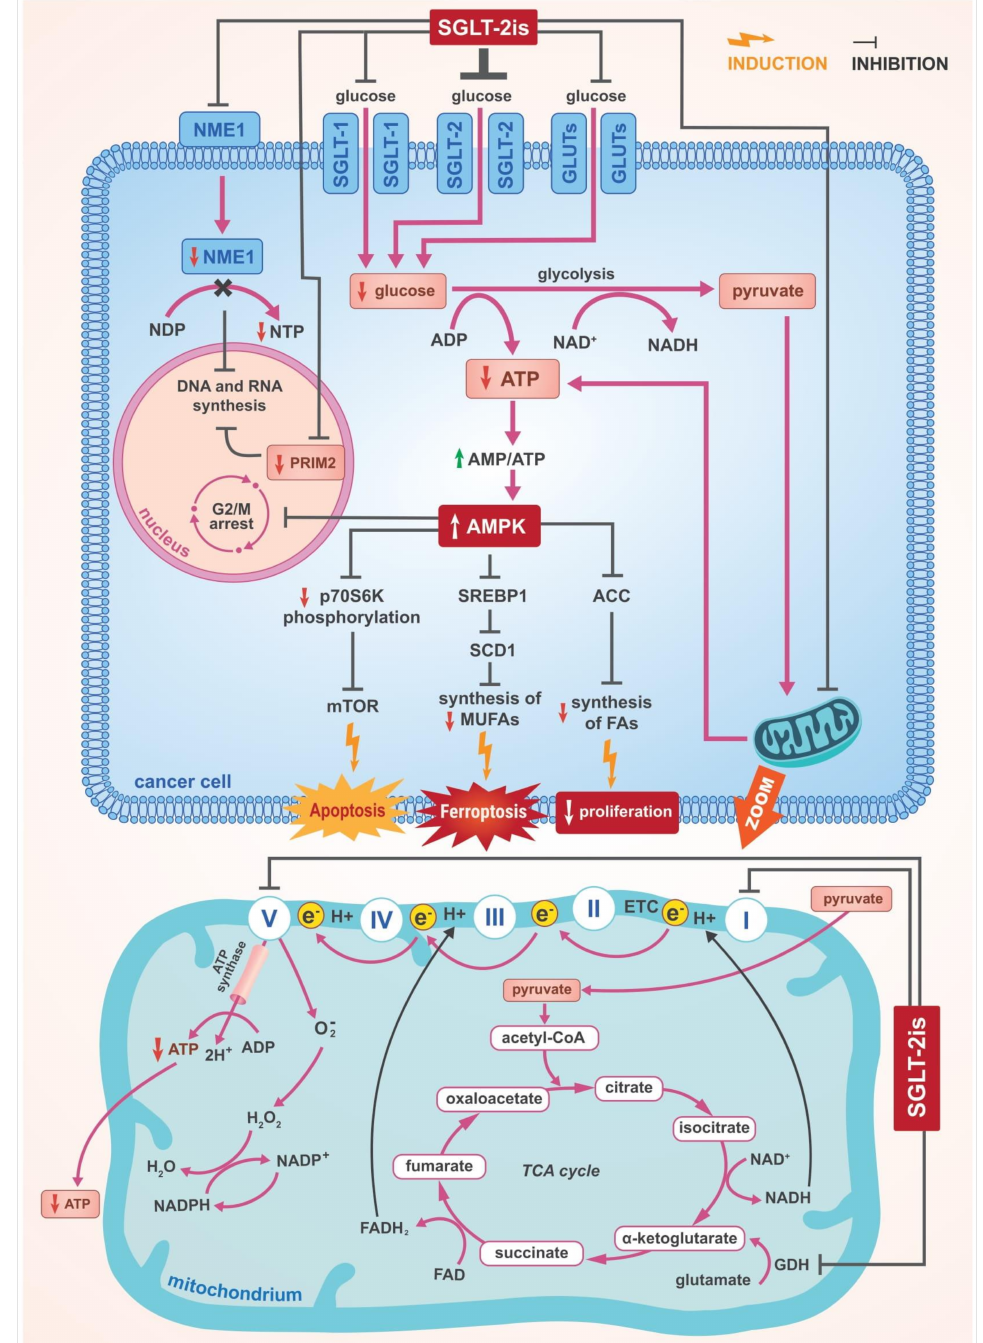
Figure 2. The main mechanisms of anti-cancer action of SGLT-2 inhibitors including the central role of AMPK activation. SGLT-2 inhibitors indirectly activate AMPK in cancer cells. SGLT-2 inhibitors, by inhibiting the oxidative phosphorylation, decrease ATP production and thus increase the AMP/ATP ratio. This leads to AMPK activation. SGLT-2 inhibitors affect oxidative phosphorylation. SGLT-2 inhibitors downregulate the alpha subunit of ATP synthase F1 and inhibit mitochondrial complex-I which leads to a significant decrease in ATP production in cancer cells. This results in an increase in the AMP/ATP ratio, which in turn causes a rapid and significant increase in AMPK activity. Another mechanism of action of SGLT-2 inhibitors, related to their effect on glutamine metabolism, also contributes to the increase in the AMP/ATP ratio. Glutamine is converted to glutamate, which is the carbon source for the TCA cycle. SGLT-2 inhibitors inhibit GDH activity, resulting in a significant decrease in intracellular alpha-ketoglutarate concentration. A fall in alpha-ketoglutarate